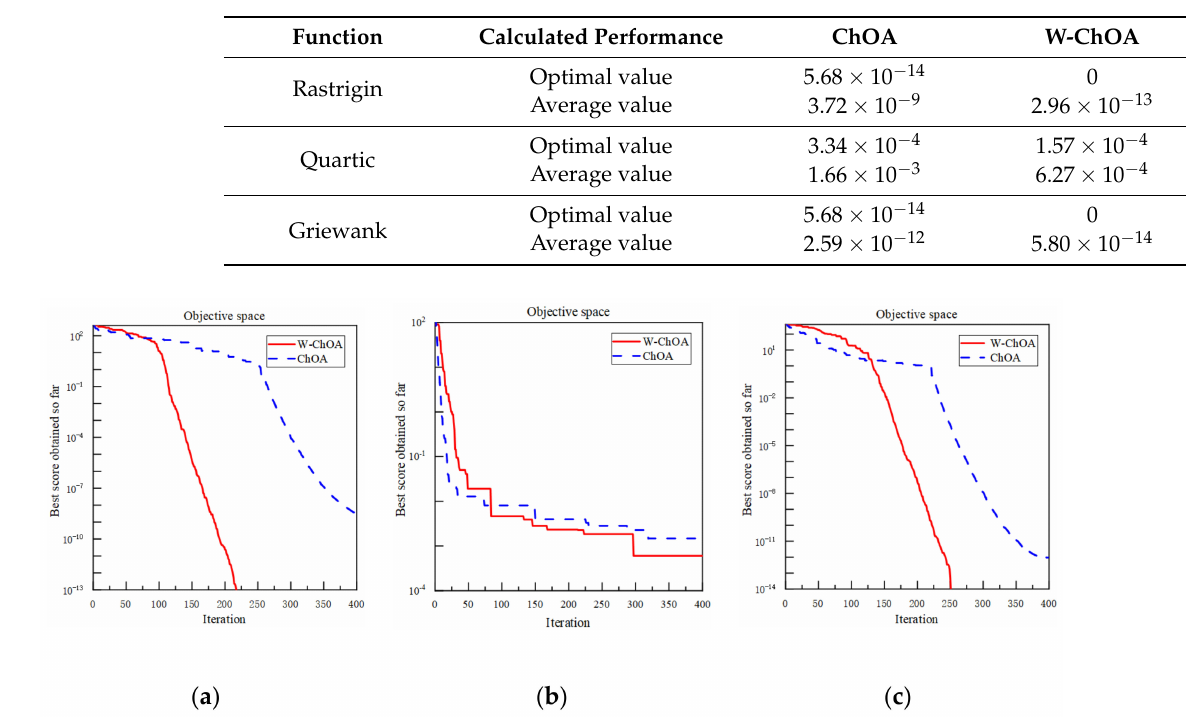
Table 2. Test results of benchmark functions.